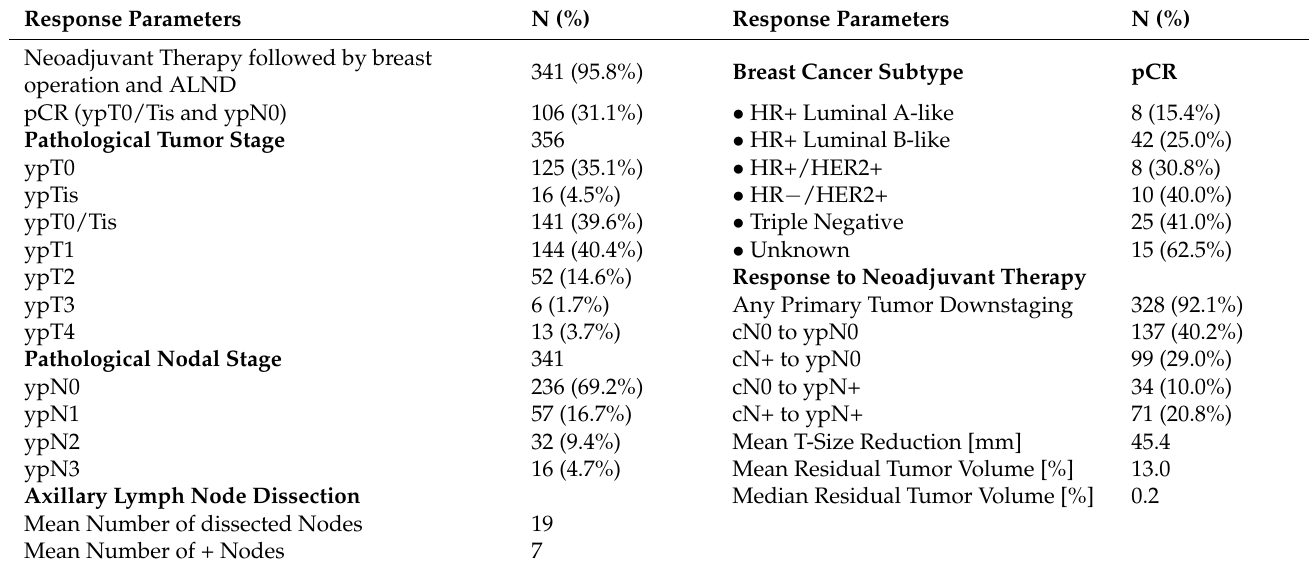
Table 2. Overview of the response parameters of the patient cohort. Data presented as absolute numbers and